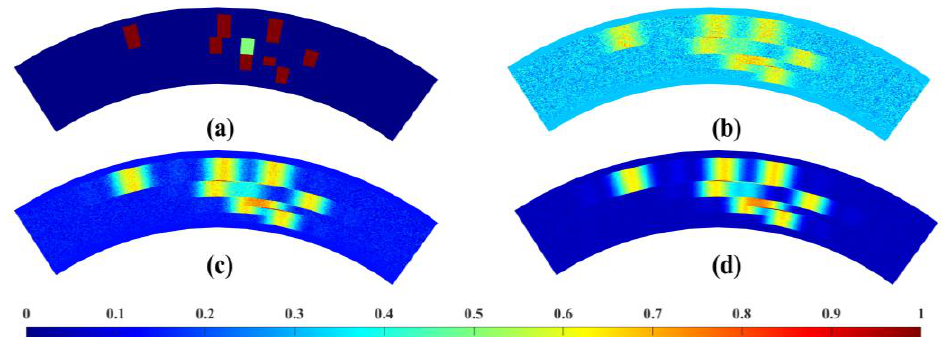
Figure 10. Simulated surface targets with convolution and noise degradation with different SNRs of simulated noise. ( a ) Simulated echo. ( b ) SNR = 5 dB. ( c ) SNR = 15 dB. ( d ) SNR = 25 dB. The results generated by these different methods are demonstrated in Figures 11 – 13.